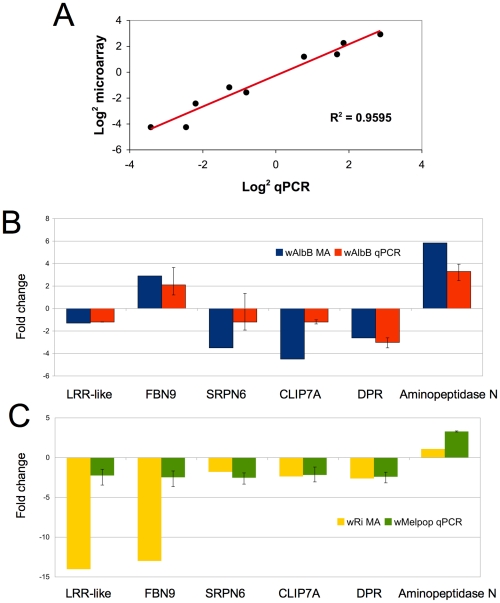
Validation of microarray data in cell culture and whole mosquitoes.A. Log2 fold change for selected An. gambiae genes (HSP20, HSP90, HSPDnaJ, cold-shock protein, cecropin, Serpin6, Filamin, TEP3) comparing microarray and QPCR methods. B. Comparison of Anopheles gene expression in response to Wolbachia in cell culture and whole mosquitoes. Expression of 6 genes from wAlbB in Sua5B cells analyzed using microarrays (MA) compared to wAlbB somatically-infected whole mosquitoes 15 days post injection (N = 5 mosquitoes/treatment). C. Microarray data from wRi infected Sua5B cells compared to wMelpop somatically-infected whole mosquitoes 15 days post injection (N = 5 mosquitoes/treatment). qPCR gene expression is a ratio of Wolbachia infected (wAlbB or wRi) to Schneider's injected control. Error bars represent maximum and minimum range of expression.